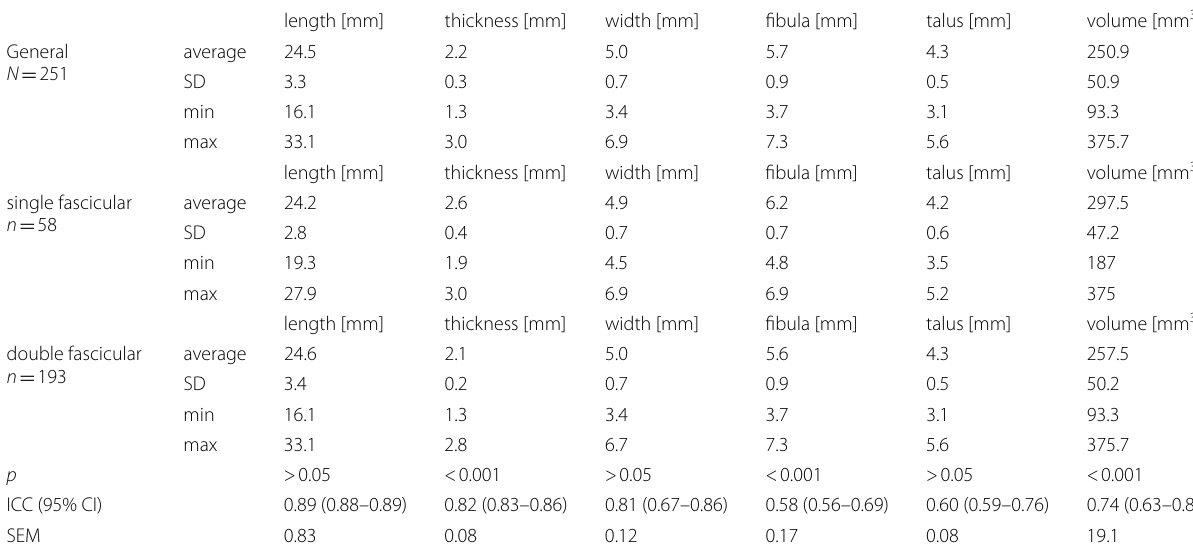
Table 1 Dimensions of the anterior talofibular ligament in the general group, single fascicular and double fascicular ligaments